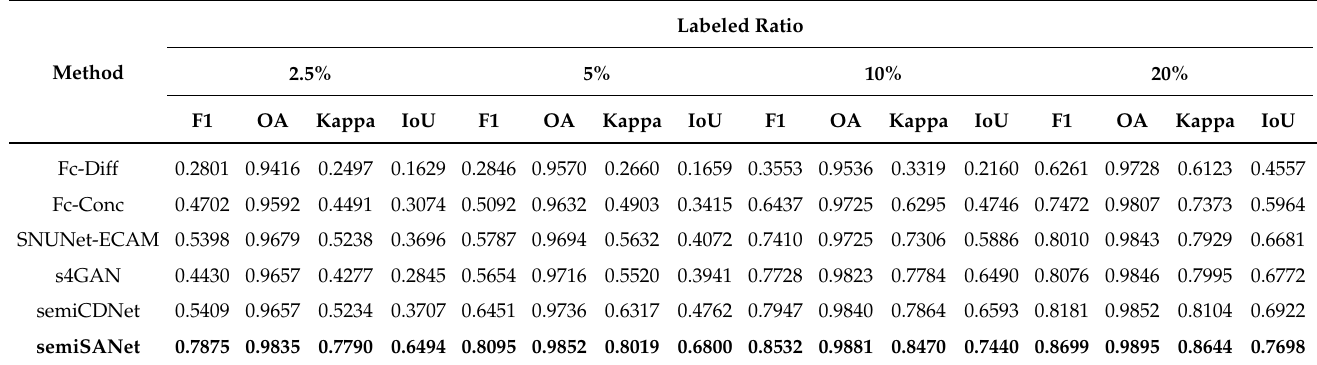
Table 2. The experimental results on the LEVIR2000 dataset.